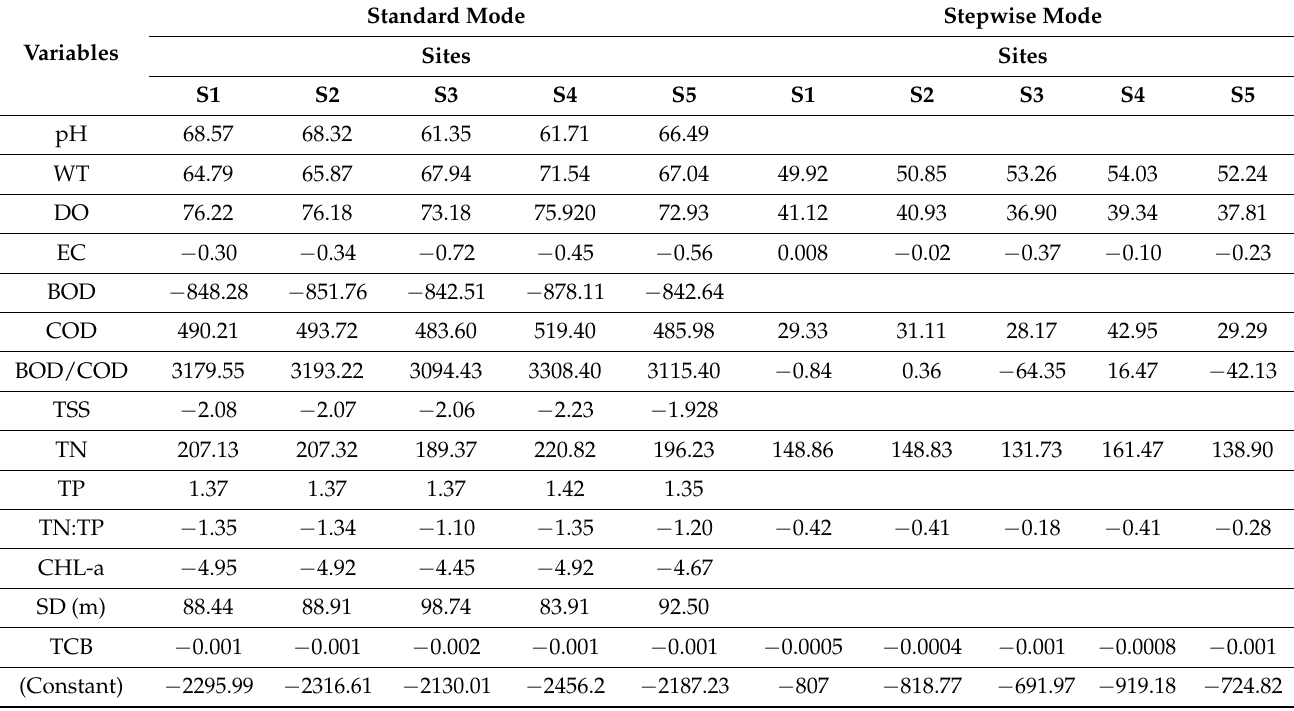
Table 2. Classification functions for discriminant analysis of spatial variations in water quality of the reservoir.